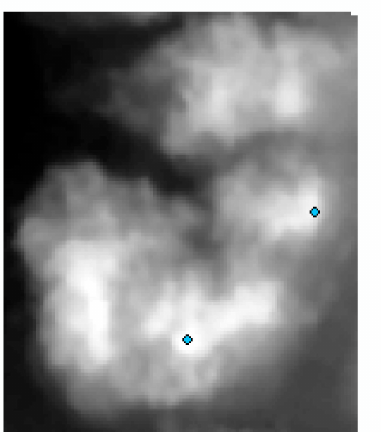
Remote Sens. 2021 , 13 , x FOR PEER REVIEW 24 of 35 Figure 25. The distribution map of the fifth dataset extracted using the reference method.